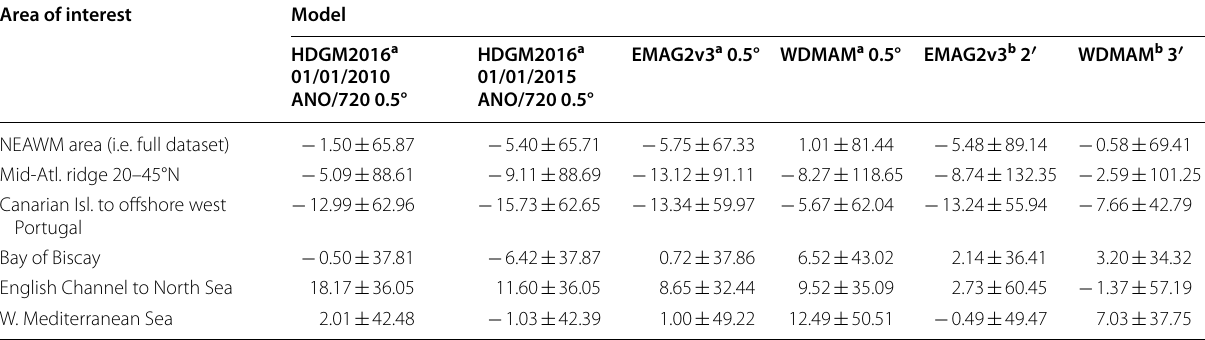
Marine data are processed and filtered a or only processed b to give spectral content comparable to that of the